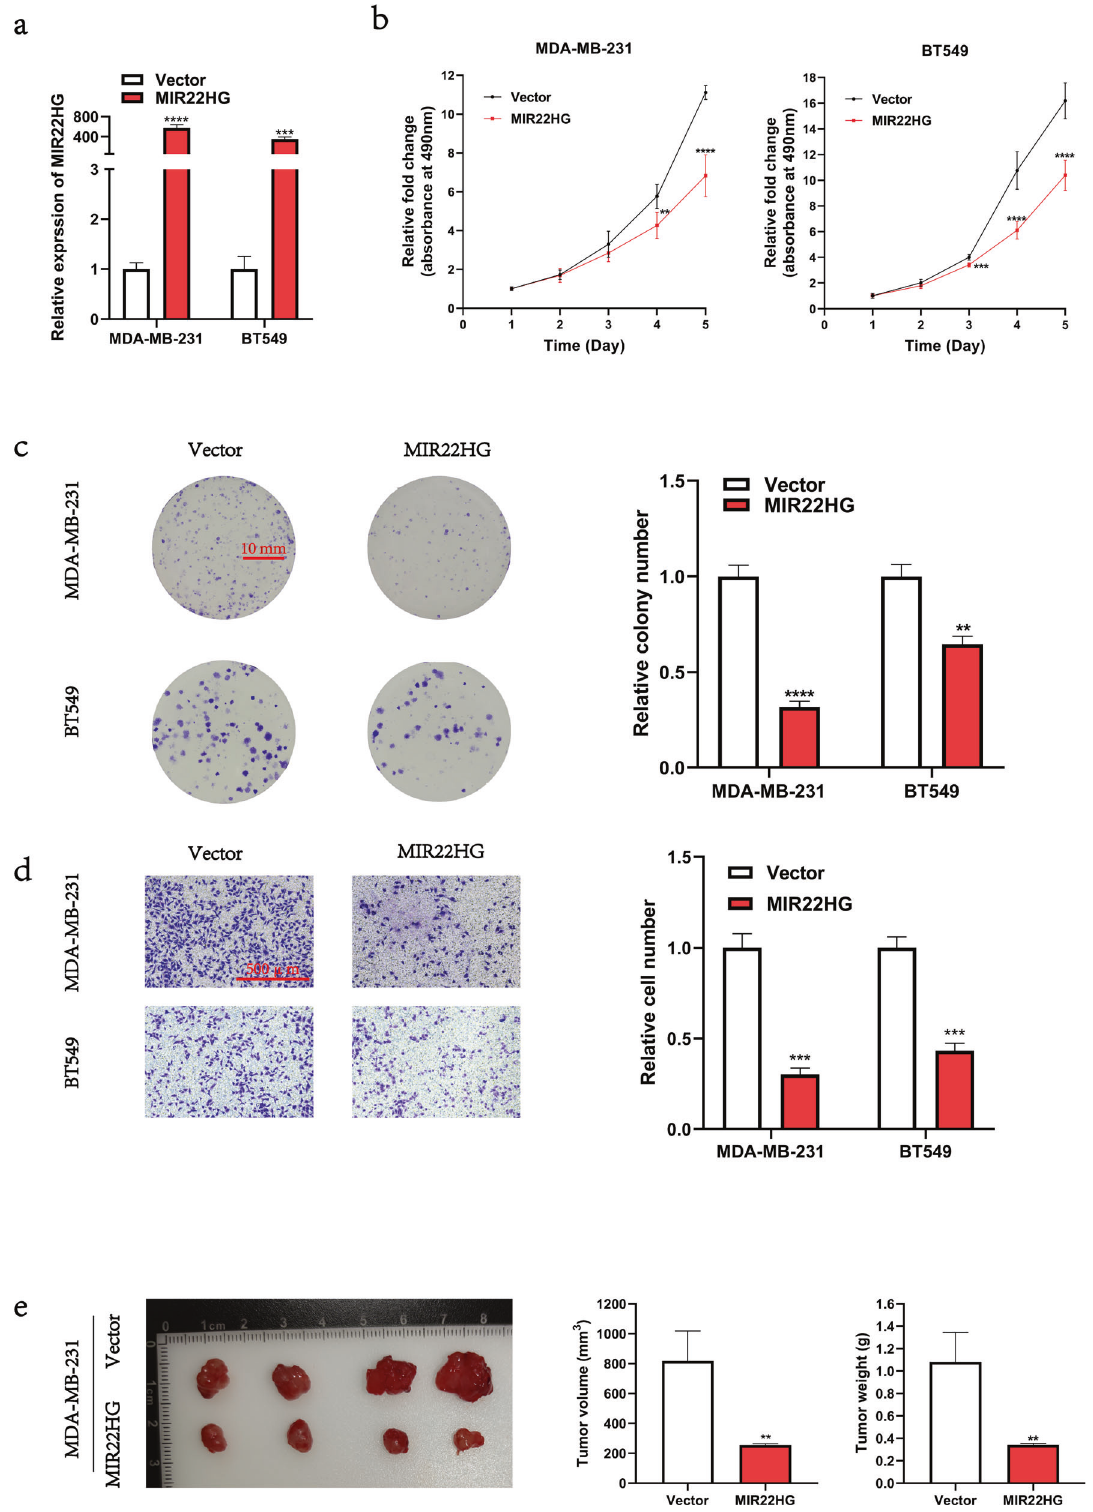
Fig. 3 Gain-of-function of MIR22HG inhibits the proliferation and migration of breast cancer cells. a Overexpression ef fi ciency of MIR22HG in MDA-MB-231 and BT549 cells after transfection with MIR22HG pcDNA3.1 plasmid for 48 h. b , c MTT assay (5-day period) and colony formation assay (18-day period) were performed to determine the viability of MDA-MB-231 and BT549 cells after transfection. d Transwell assay (20-h period, 3 × 10 4 cells per well) was used to evaluate the migration ability of MDA-MB-231 and BT549 cells after MIR22HG overexpression (100× magni fi cation). e A subcutaneous xenograft model was utilized to explore the biological function of MIR22HG in vivo. The MDA-MB-231 cells that stably expressed MIR22HG were subcutaneously injected into 6-week-old BALB/c nu/nu female mice. After 30 days, the tumors were collected, and the tumor volume and weight were measured. ** P < 0.01, *** P < 0.001, **** P < 0.0001. All experiments were repeated